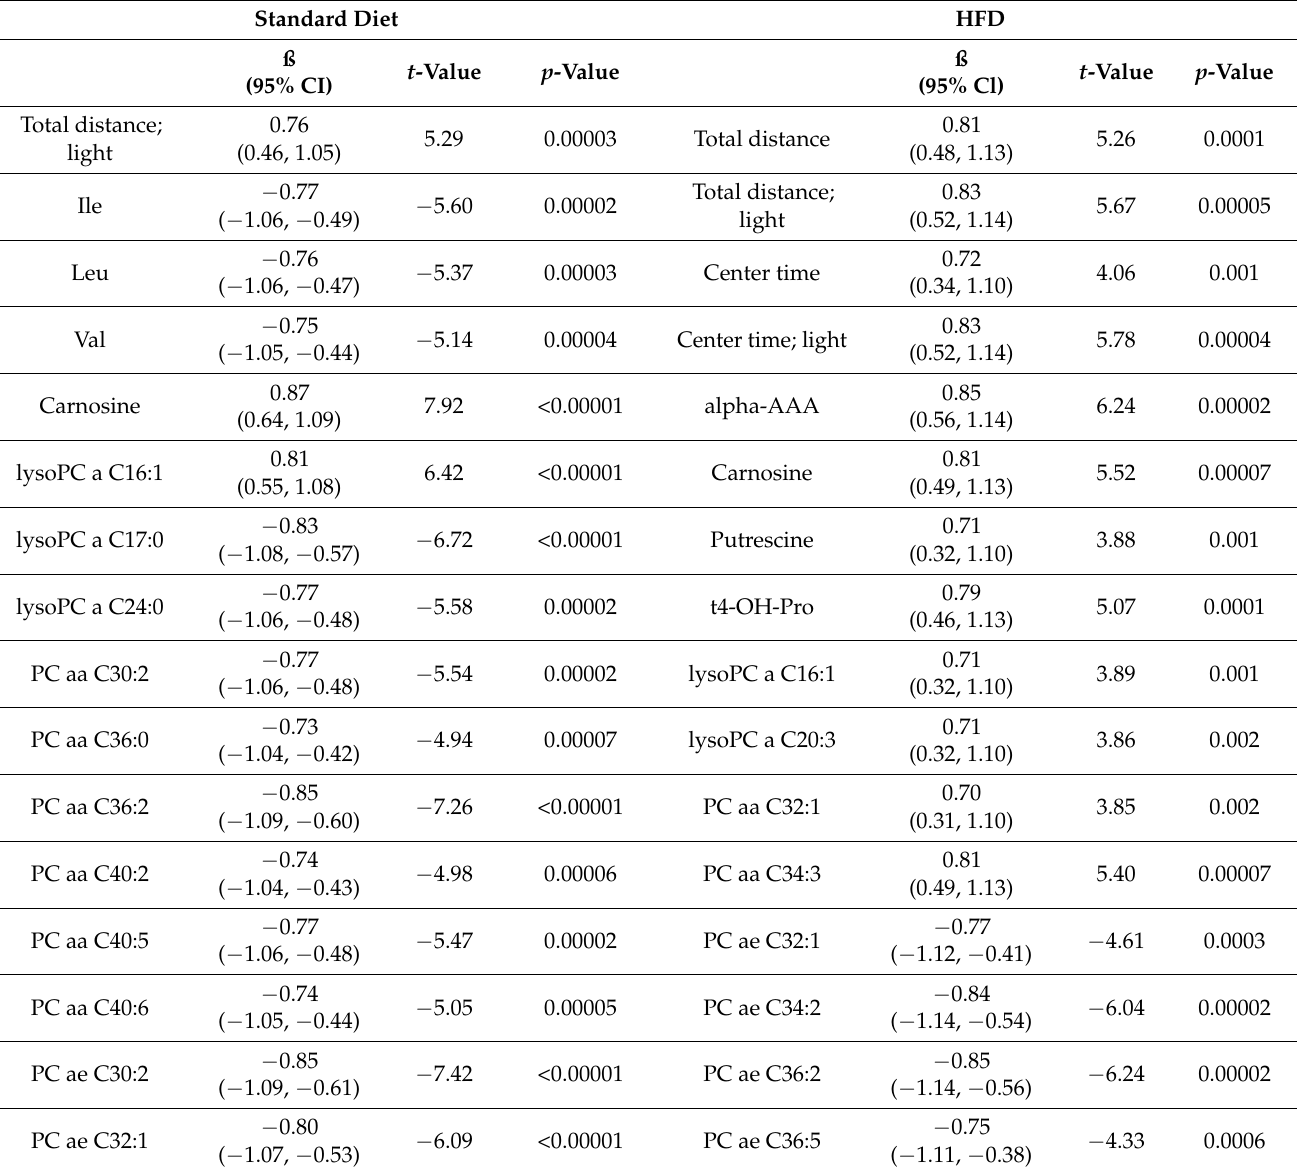
Table 1. Effect of mouse strain on blood plasma levels of metabolites and locomotor parameters between standard diet groups and HFD